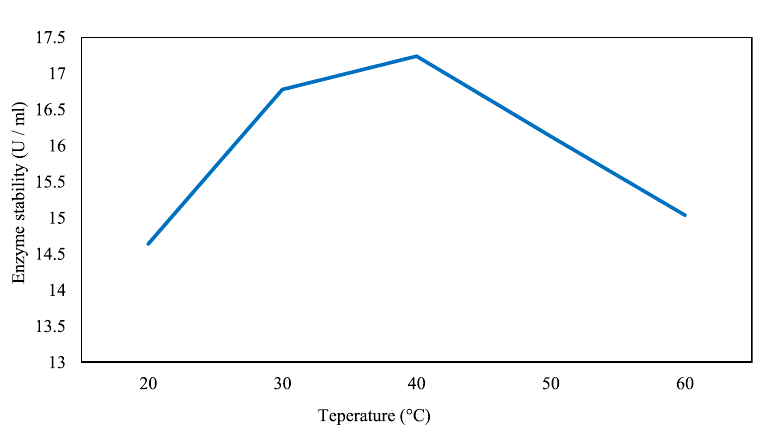
Fig. 14. Effect of different temperatures on stability of the purified β- xylosidase